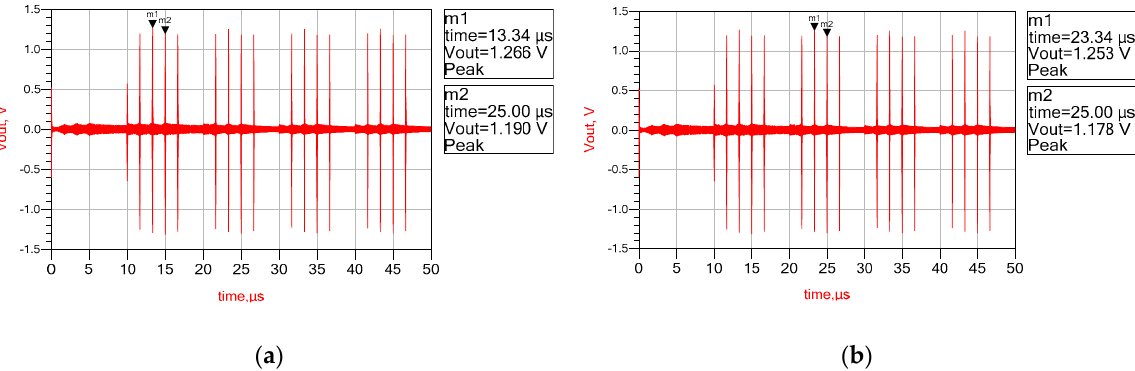
Figure 5. Output pulses of the four input frequencies. ( a ) is compressed by the classical two-channel chirp transform spectrometer (CTS) structure; ( b ) is compressed by the TDS M-C arrangement.